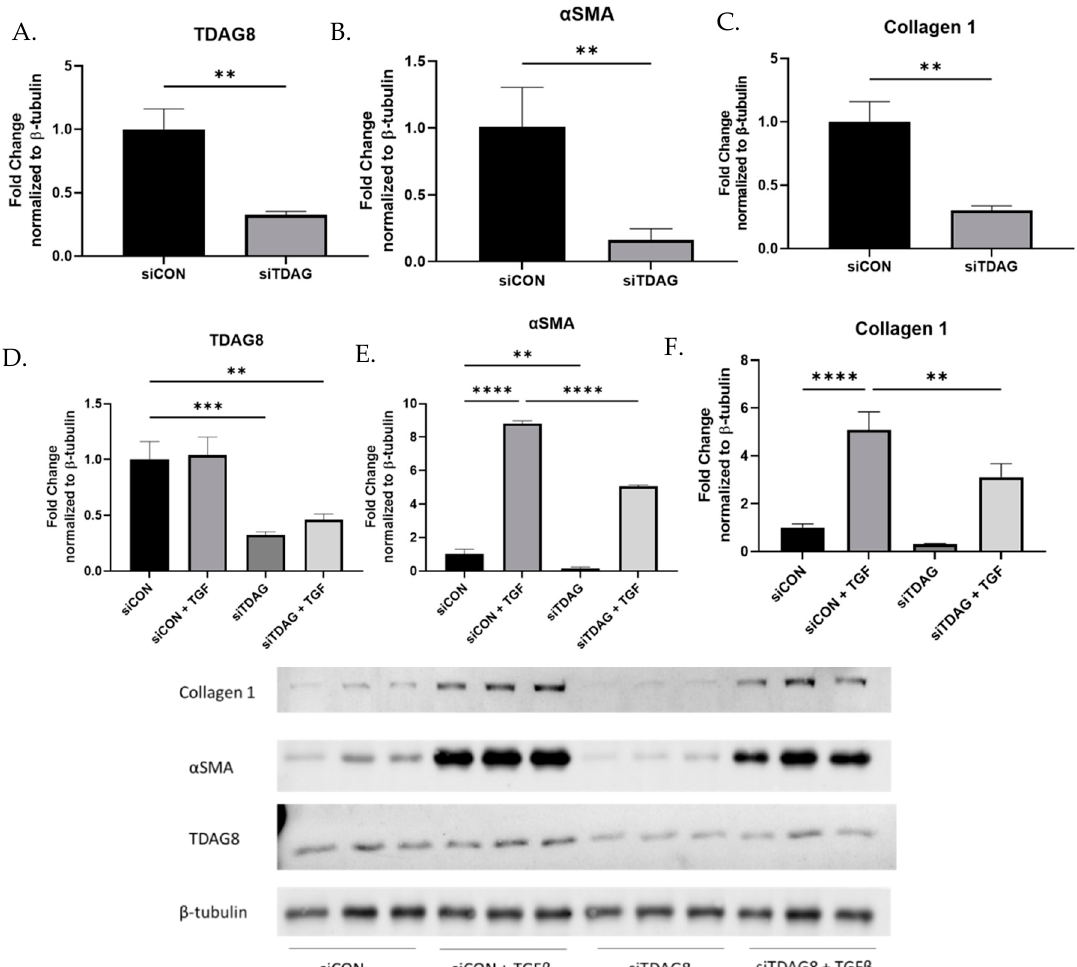
Figure 2. TDAG8 knockdown reduces the ability of TGF β to induce myofibroblast differentiation. Primary human lung fibroblasts were transfected with non-targeting control siRNA or siRNA specific to TDAG8 for 16 h, upon which media was changed, adding 1 ng/mL TGF β where indicated, and harvested after 80 h. Lysates were examined for the expression of TDAG8, α SMA and collagen 1 at baseline ( A – C ) and in response to TGF β ( D – F ). Data were analyzed by t -test, in the case of two groups, or ANOVA where there are multiple groups. n = 3/group. ** p < 0.01, *** p < 0.05 **** p < 0.0001.